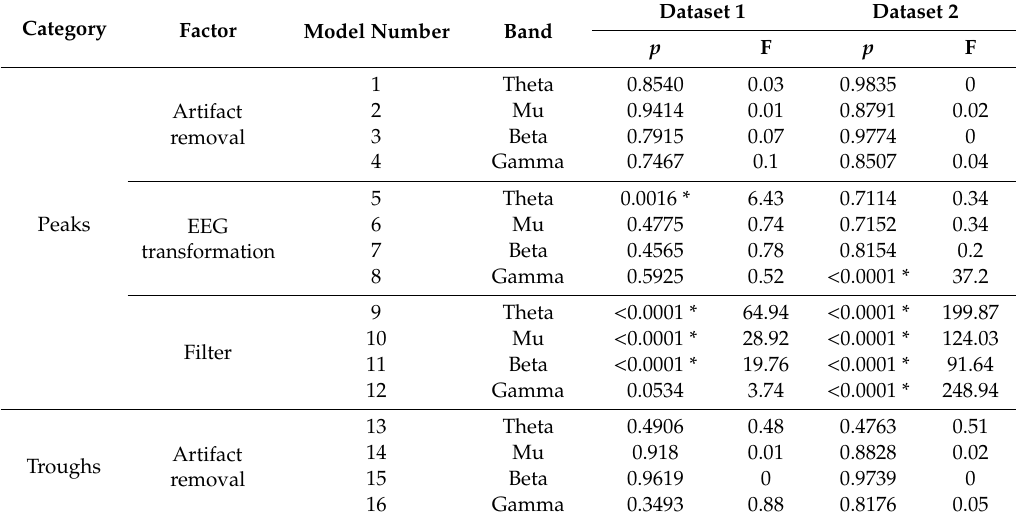
Table 2. The results of 48 linear mixed effect models (24 for Dataset 1 and 24 for Dataset 2), where the response variable was the phase of the signal. The effects of choices in artifact removal, EEG transformation, and filter are outlined in the table. The effects are shown separately for each frequency bands. Significant p -values are marked with asterisks (*).